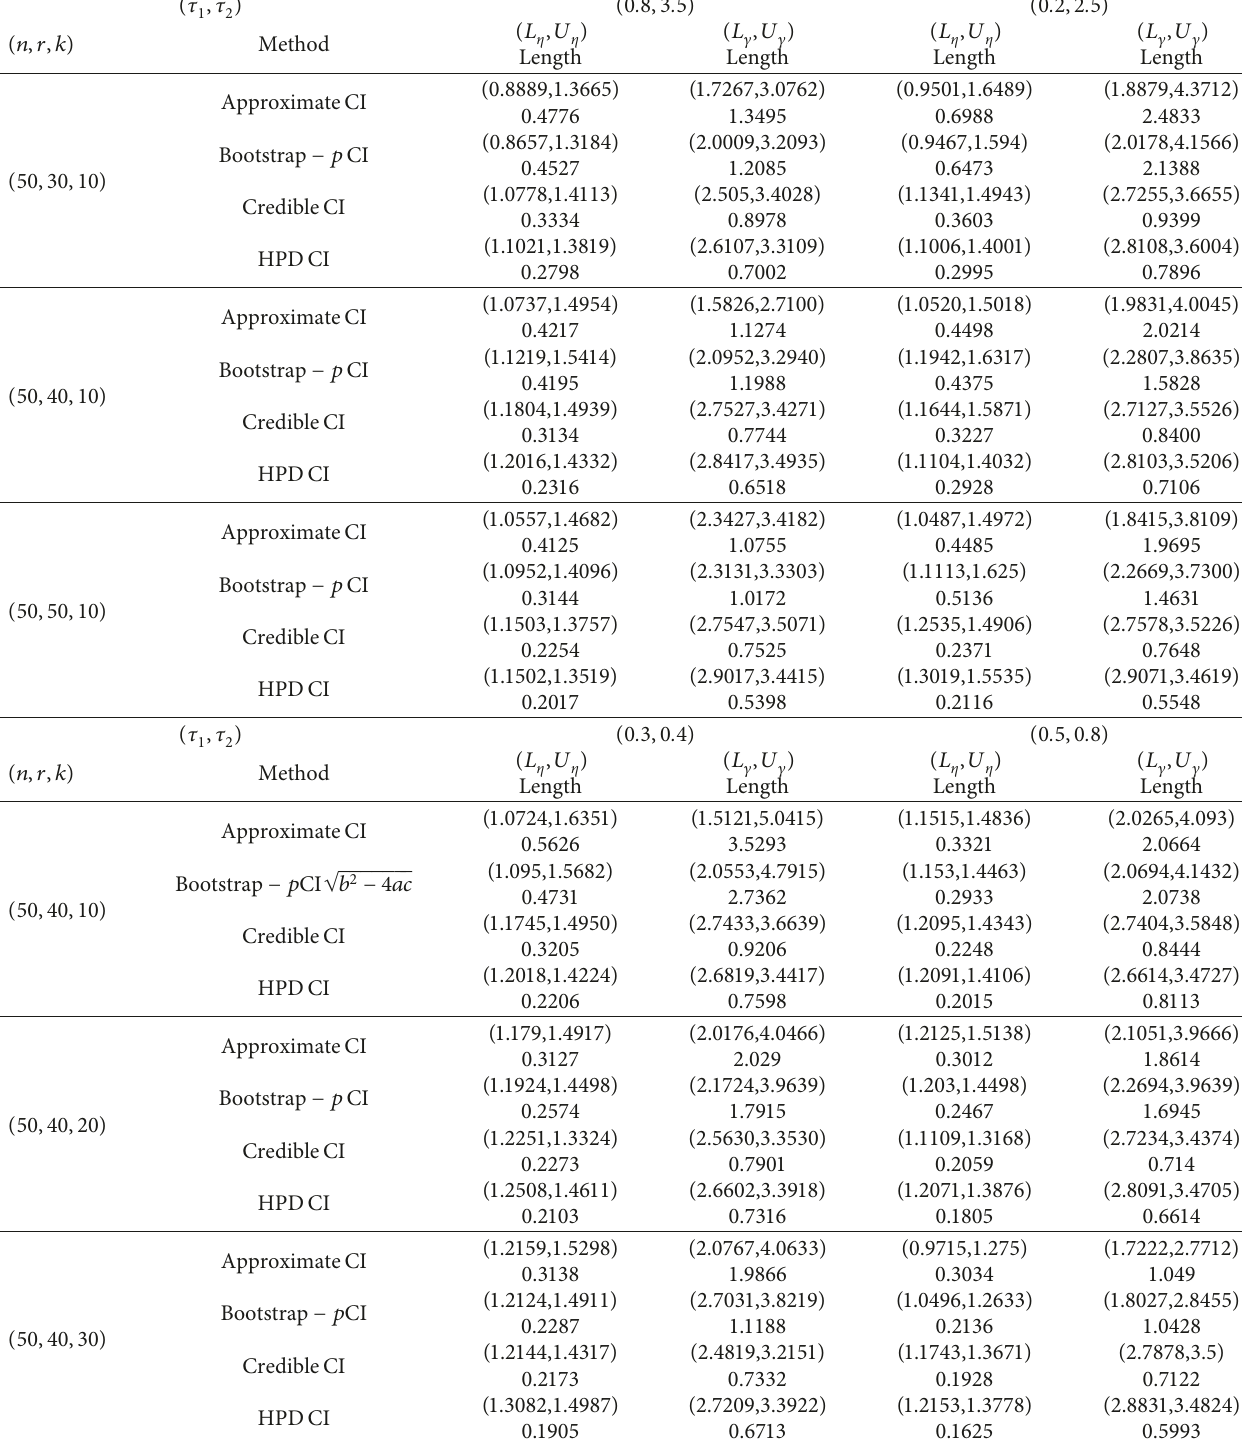
Table 2: Parameters interval